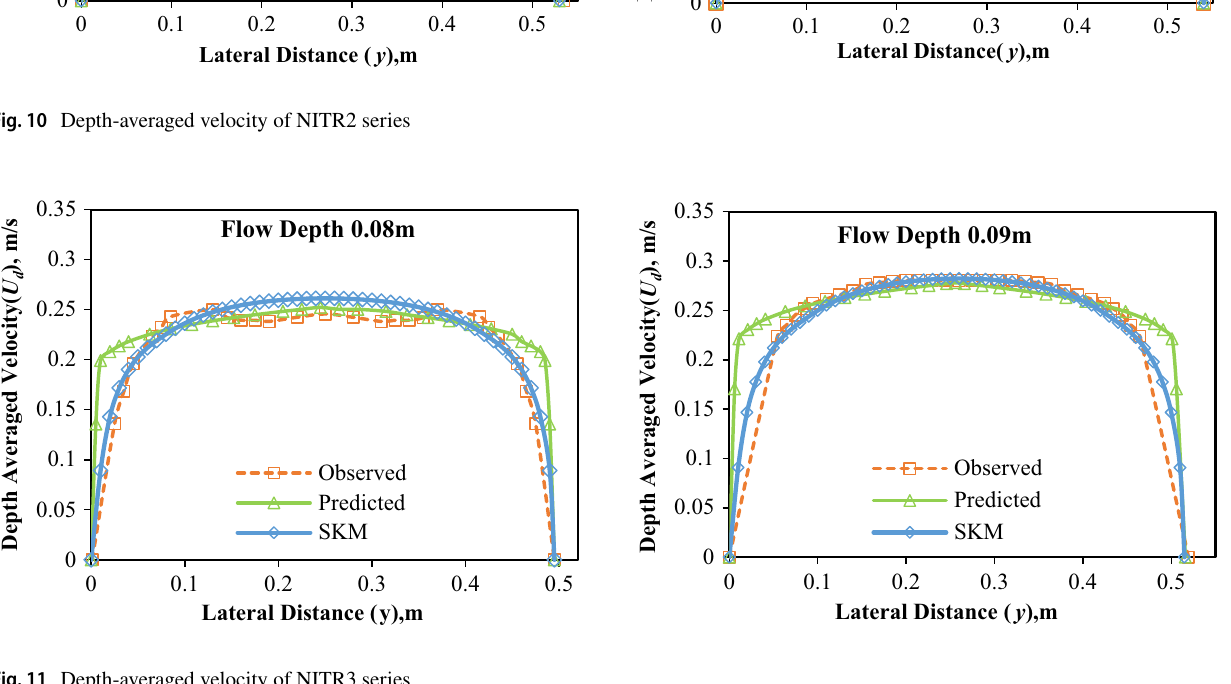
Fig. 11 Depth-averaged velocity of NITR3